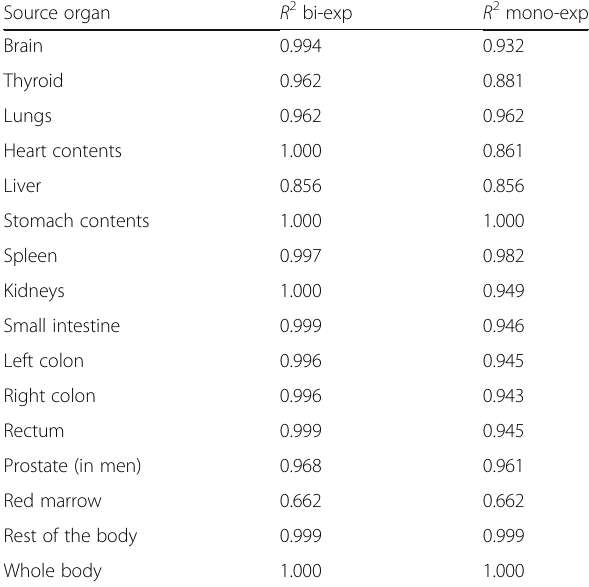
Table 1 Goodness of fit expressed by the coefficient of determination R 2 for considered source organs average nA values fitted with mono- and bi-exponential functions (averaged nA and fits are visible in Fig. 1). The average nA were computed from experimental data collected across the six-patient dataset